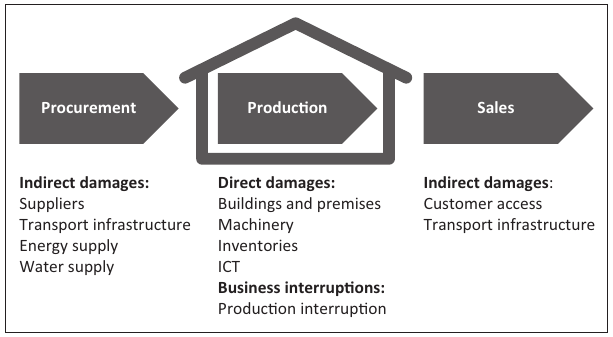
FIGURE 2: Damage types and assets at risk included in the survey along the value